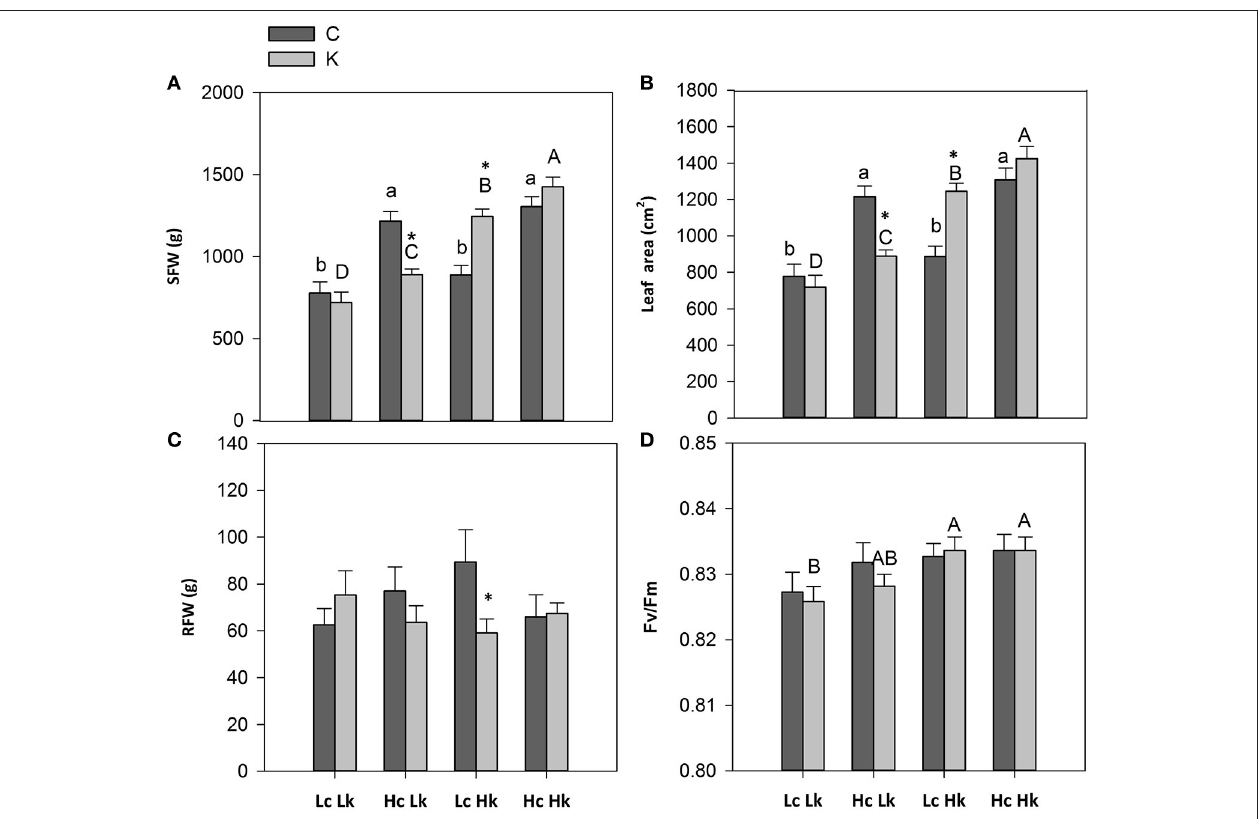
FIGURE 1 | Shoot fresh weight (SFW) (A) , leaf area (LA) (B) , root fresh weight (RFW) (C) , and chlorophyll fluorescence (F v /F m ) (D) of the scion ( Solanum lycopersicum cv. Boludo F1) grafted onto a population of recombinant inbred lines (RILs) from a cross between Solanum lycopersicum × Solanum pimpinellifolium with high ( H ) or low ( L ) vigor growing under control ( c ) and low ( k ) conditions during 48 days. Different letters indicate significant differences among graft combinations ( n = 12, P < 0.05) within each treatment. *indicate significant differences between control and low-K treated plants according to the Tuckey test ( P <